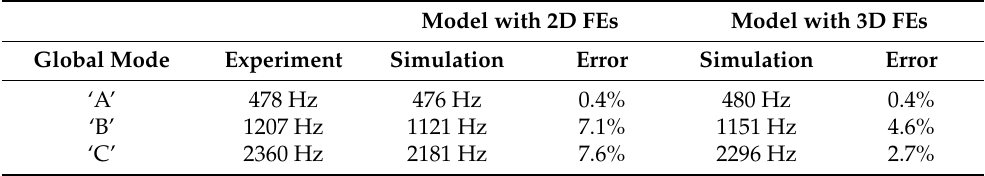
Table 3. Natural frequencies of the test sample.